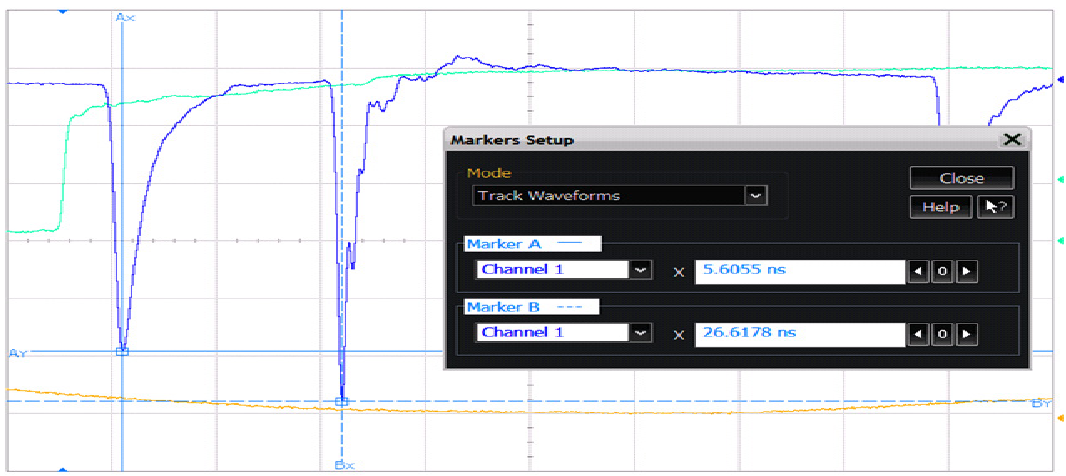
Figure 5. Signal waveforms measured by the Beam Current Transformers (BCTs).